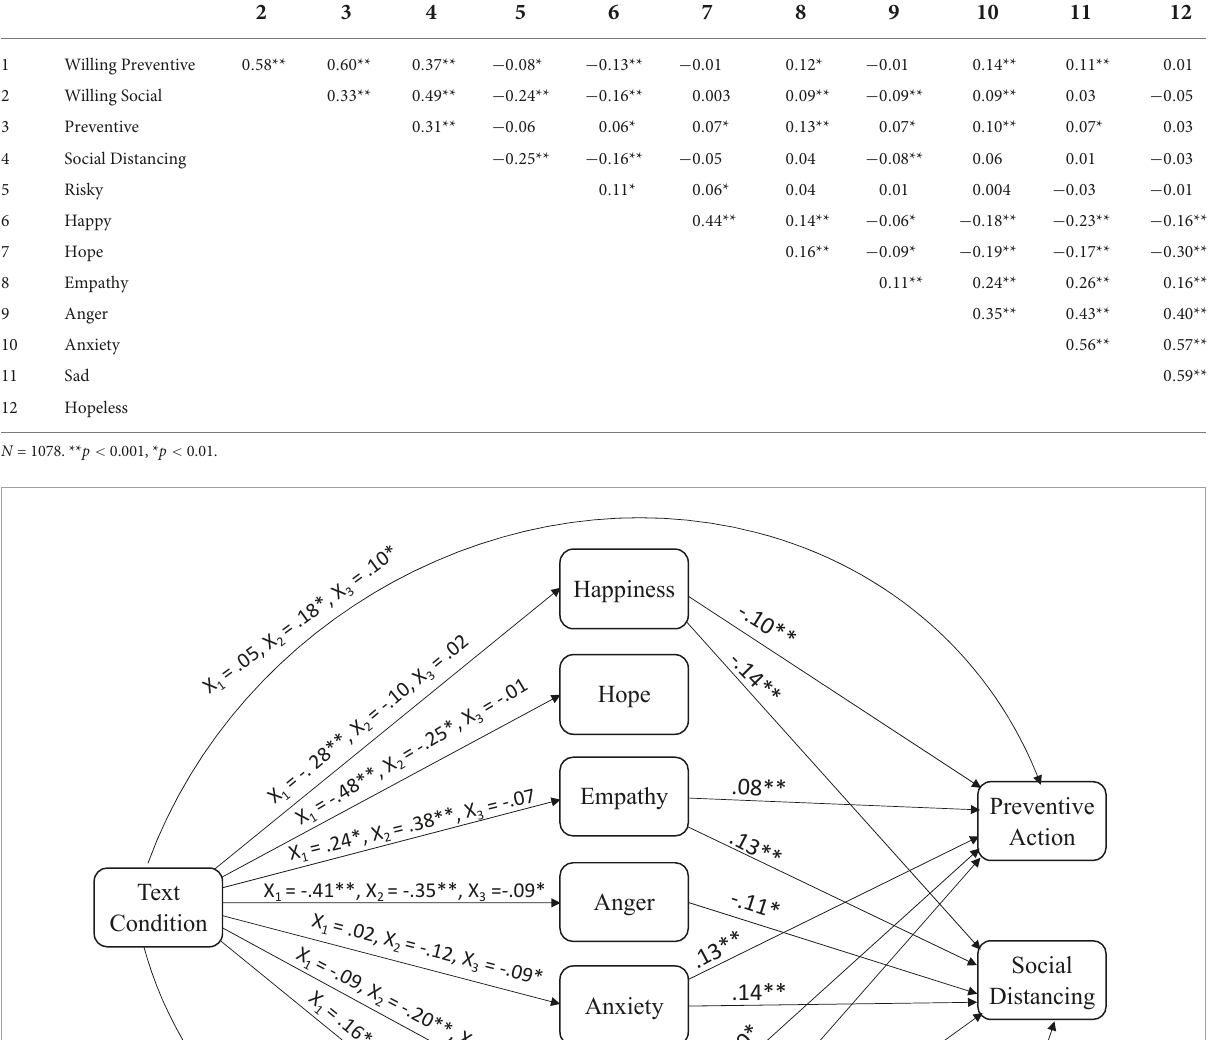
FIGURE3 Model of relations between text condition, emotions, and willingness to engage in preventive action. Standardized effects; only significant paths are shown for emotions to outcomes to reduce complexity. ∗ p < 0.05 and ∗∗ p < 0.01.